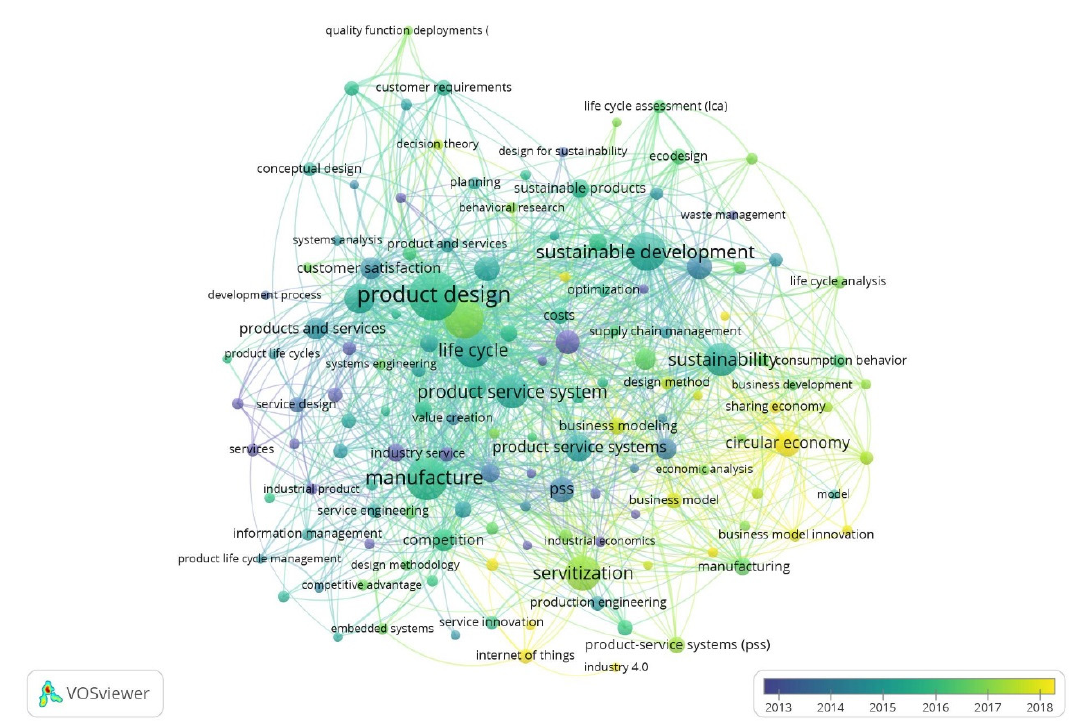
Figure 8. Product-services systems keywords over time.